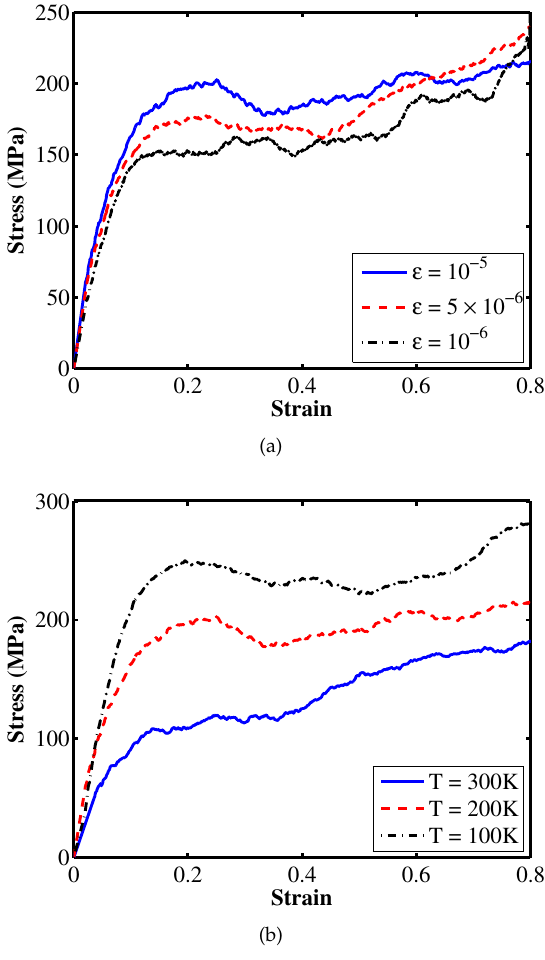
Figure 4. Uniaxially tensile stress-strain responses for the PE deformed ( a ) at temperature of 200 K for different strain rates; ( b ) at a strain rate of 10 − 5 1/fs for different